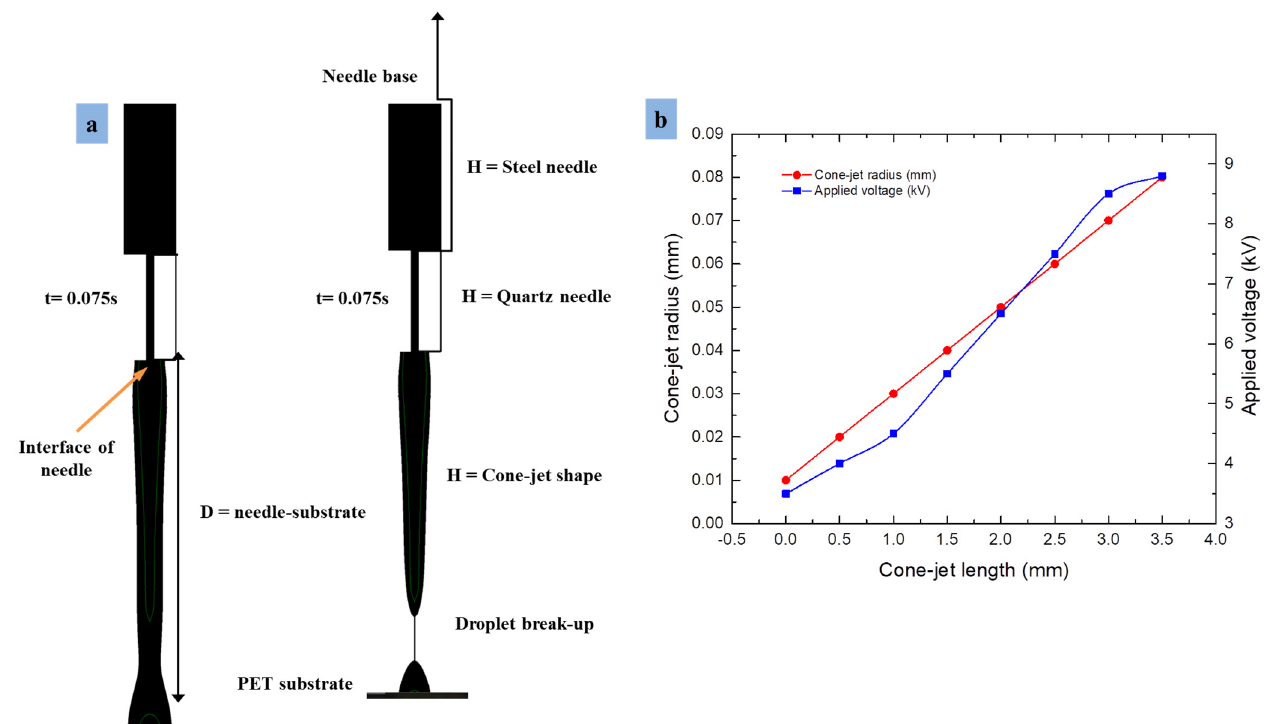
Figure 11. Formation of cone jet and microdroplets at different distances between needle tip to sub- strate: ( a ) 240 μ m and 200 μ m; ( b ) relationship between cone-jet radius and cone-jet length. substrate: ( a ) 240 µ m and 200 µ m; ( b ) relationship between cone-jet radius and cone-jet